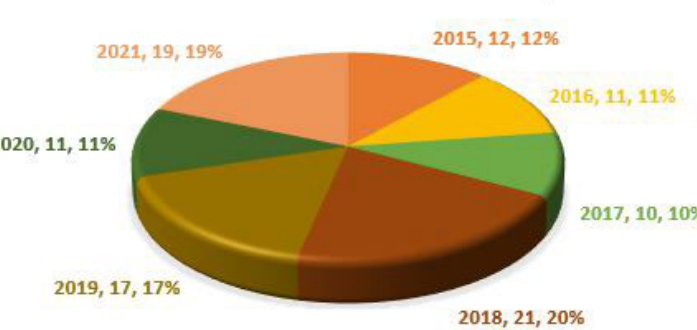
Figure 2. Published articles distribution between 2015–2021. From 2015 to 2021 (Figure 3), there are 514 authors. Only 1 author has four articles, 2 have three articles, 26 have two articles, and the others (485) one article.